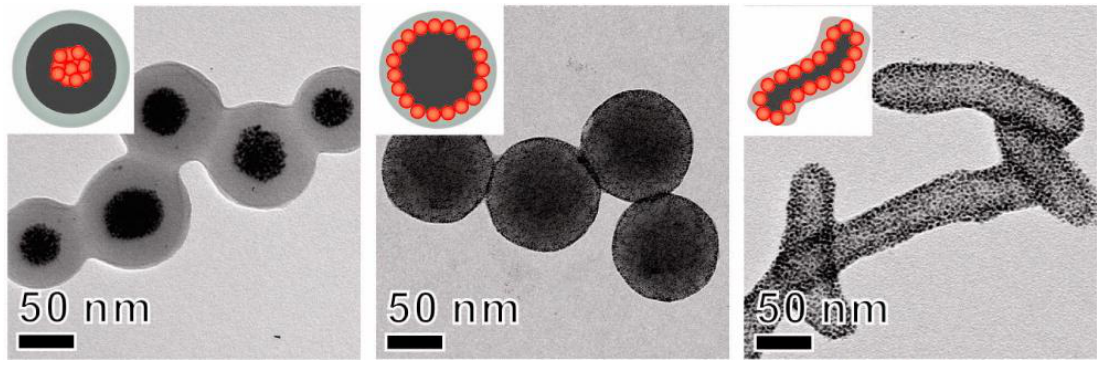
Figure 6. Using inorganic particle surface modification to control the placement of gold nanoparticles in a polysytrene- block -poly(acrylic acid) copolymer. Reprinted with permission from [48]. Copyright 2013, American Chemical